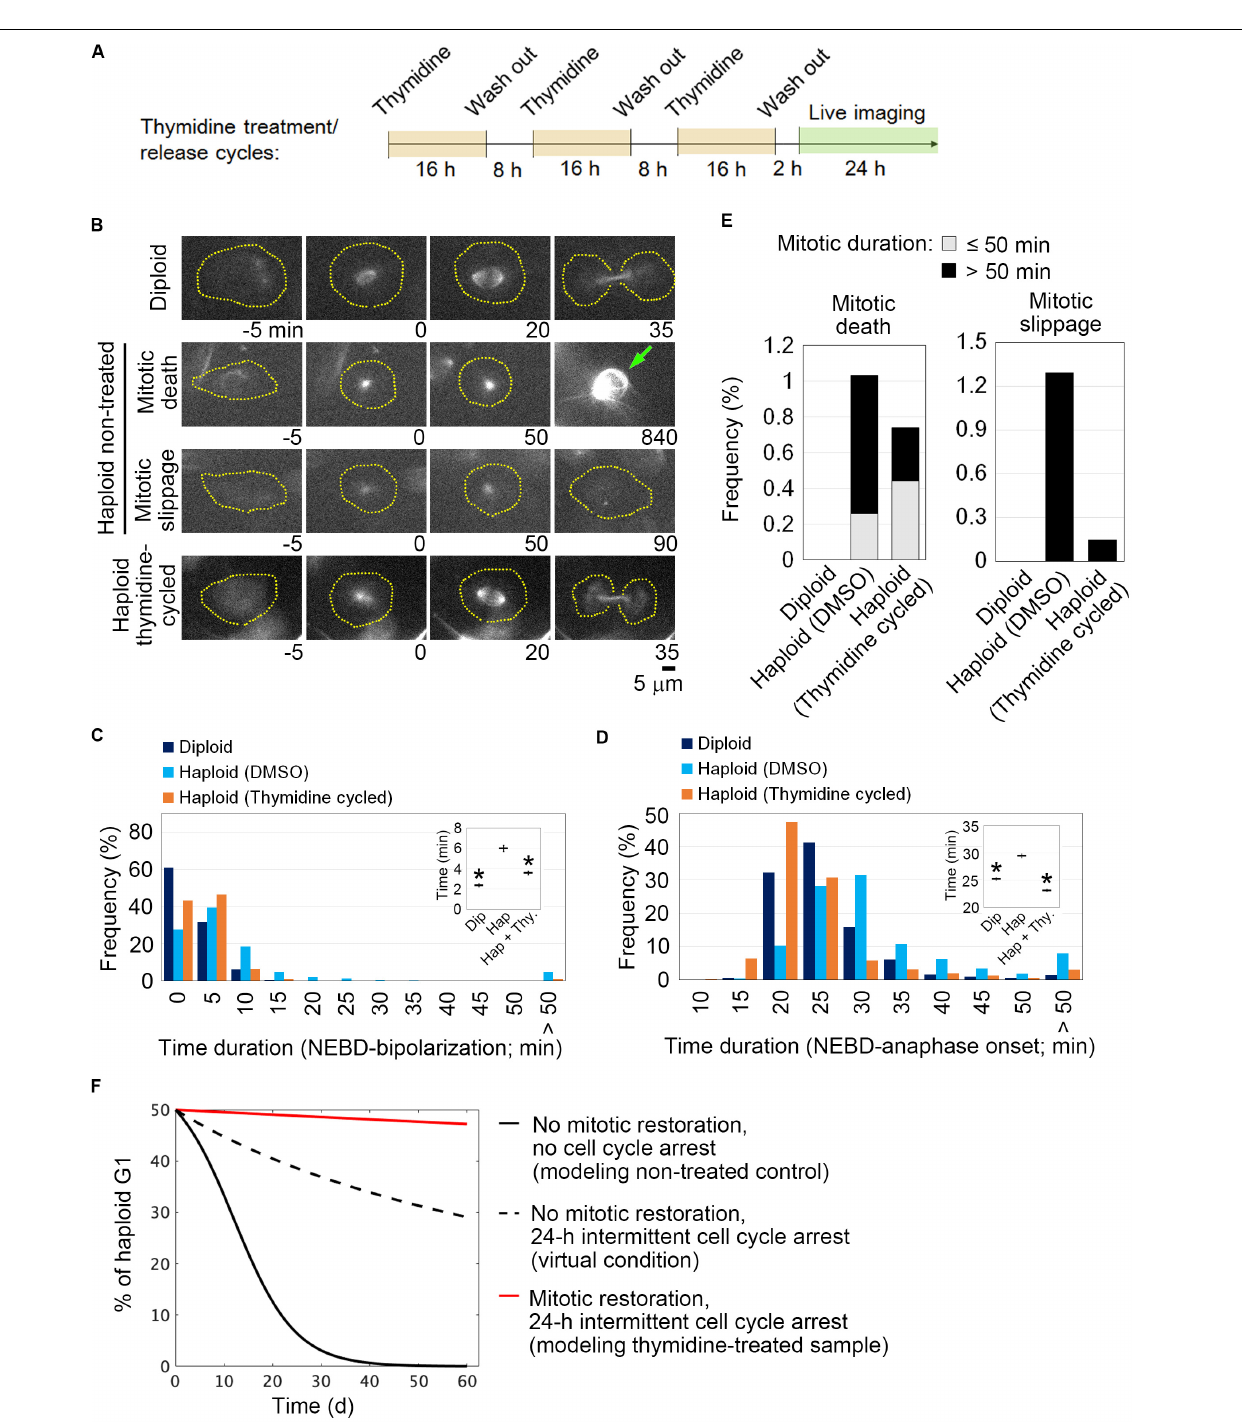
FIGURE 1 | Restoration of mitotic progression by intermittent extension of G1/S phase in haploid HAP1 cells. (A) Experimental scheme of thymidine treatment/release cycles. (B) Live images of SiR-tubulin-stained HAP1. Images were taken at 5-min intervals. NEBD was set as 0 min. Broken lines: cell boundaries. Arrow: a dead cell. (C,D) Distribution of time duration for monopolar-to-bipolar conversion (C) or NEBD-to-anaphase transition (D) . At least 393 cells from two independent experiments were analyzed. NEBD or anaphase onset was defined as the time when the nuclear structure devoid of SiR-tubulin disappeared or when the spindle structure initiated the anaphase elongation, respectively. Insets: Means ± standard error (SE). Asterisks indicate a statistically significant difference from non-treated haploid control ( ∗ p < 0.01, two-tailed t -test). Cells that showed extreme delay ( > 50 min) were excluded from the mean calculation as outliers. (E) The frequency of mitotic defects. At least 387 cells pooled from two independent experiments were analyzed. (F) Theoretical model simulation of haploid instability in long-term culture with or without intermittent cell cycle arrest and/or mitotic restoration.